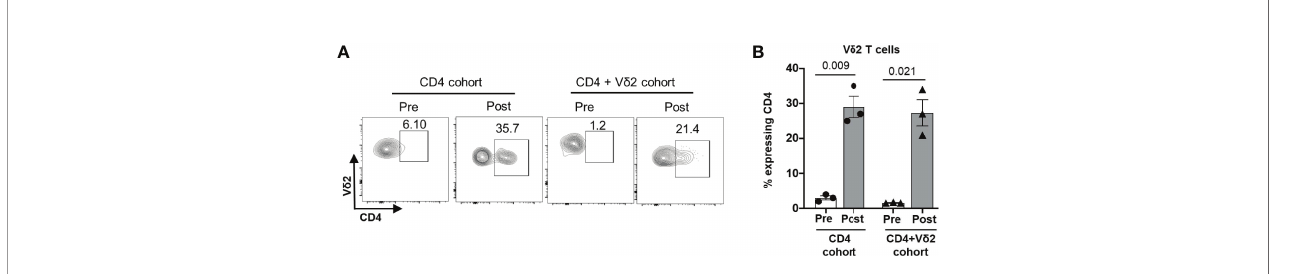
FIGURE 8 | Induction of CD4 expression on V d 2 T cells in vivo during HIV infection. CD4 + T cells from an HIV-positive individuals were administered to BLT huMice with or without co-transfer of in vitro activated V d 2 T cells. (A) Representative fl ow cytometry analysis of CD4 expression on V d 2 T cells before and after cell transplant. (B) CD4 expression on human V d 2 T cells from the BLT huMice was measured by fl ow cytometry analysis pre-and post- (2 weeks) cell transplant. Data are presented as mean values ± SEM. P values were determined using a two-tailed paired t-test within the